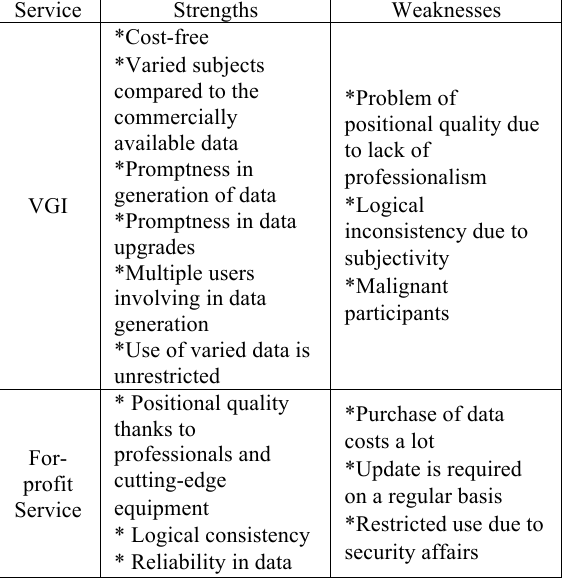
Table 1. Comparison between VGI and for-profit service